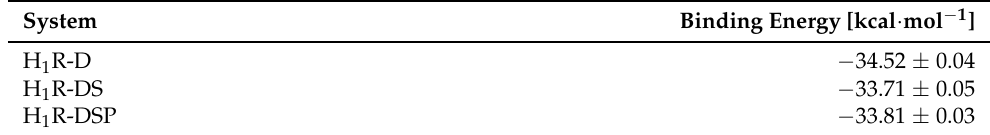
Table 1. Interaction energies between doxepin and the H 1 receptor. Averages and standard errors of mean ( n = 10,000 frames from the second half of the simulations) were calculated for the binding energies using MM/GBSA. Values are averaged over two independent simulation runs for each